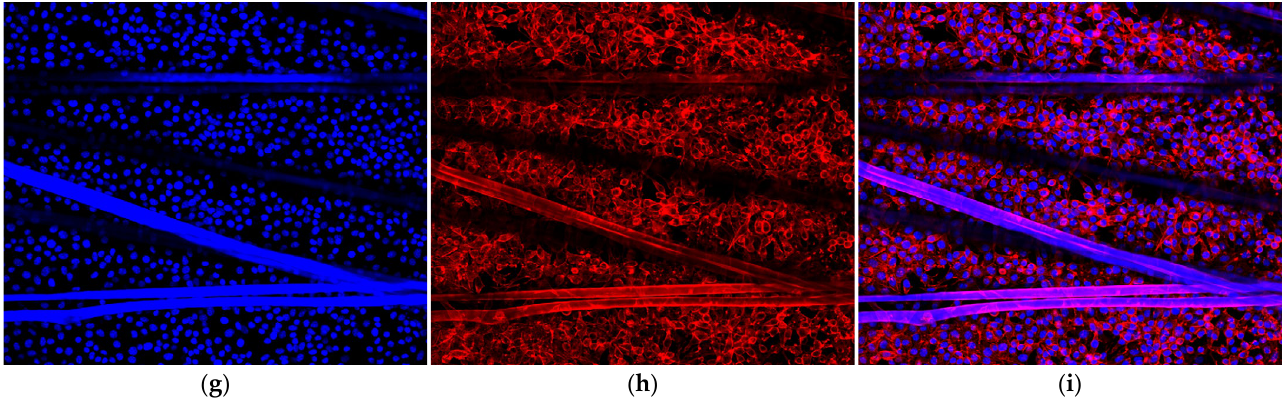
Figure 12. LSCM images of L929 cells cultured for 72 h on coverslip ( a – c ), control ( d – f ) and CDs-0.50% silk scaffolds ( g – i ); ( a , d , g ) L929 cells/silk scaffolds stained with DAPI; ( b , e , h ) L929 cells/silk scaffolds stained with rhodamine–phalloidin; ( c , f , i ) L929 cells/silk scaffolds stained with DAPI and rhodamine–phalloidin.